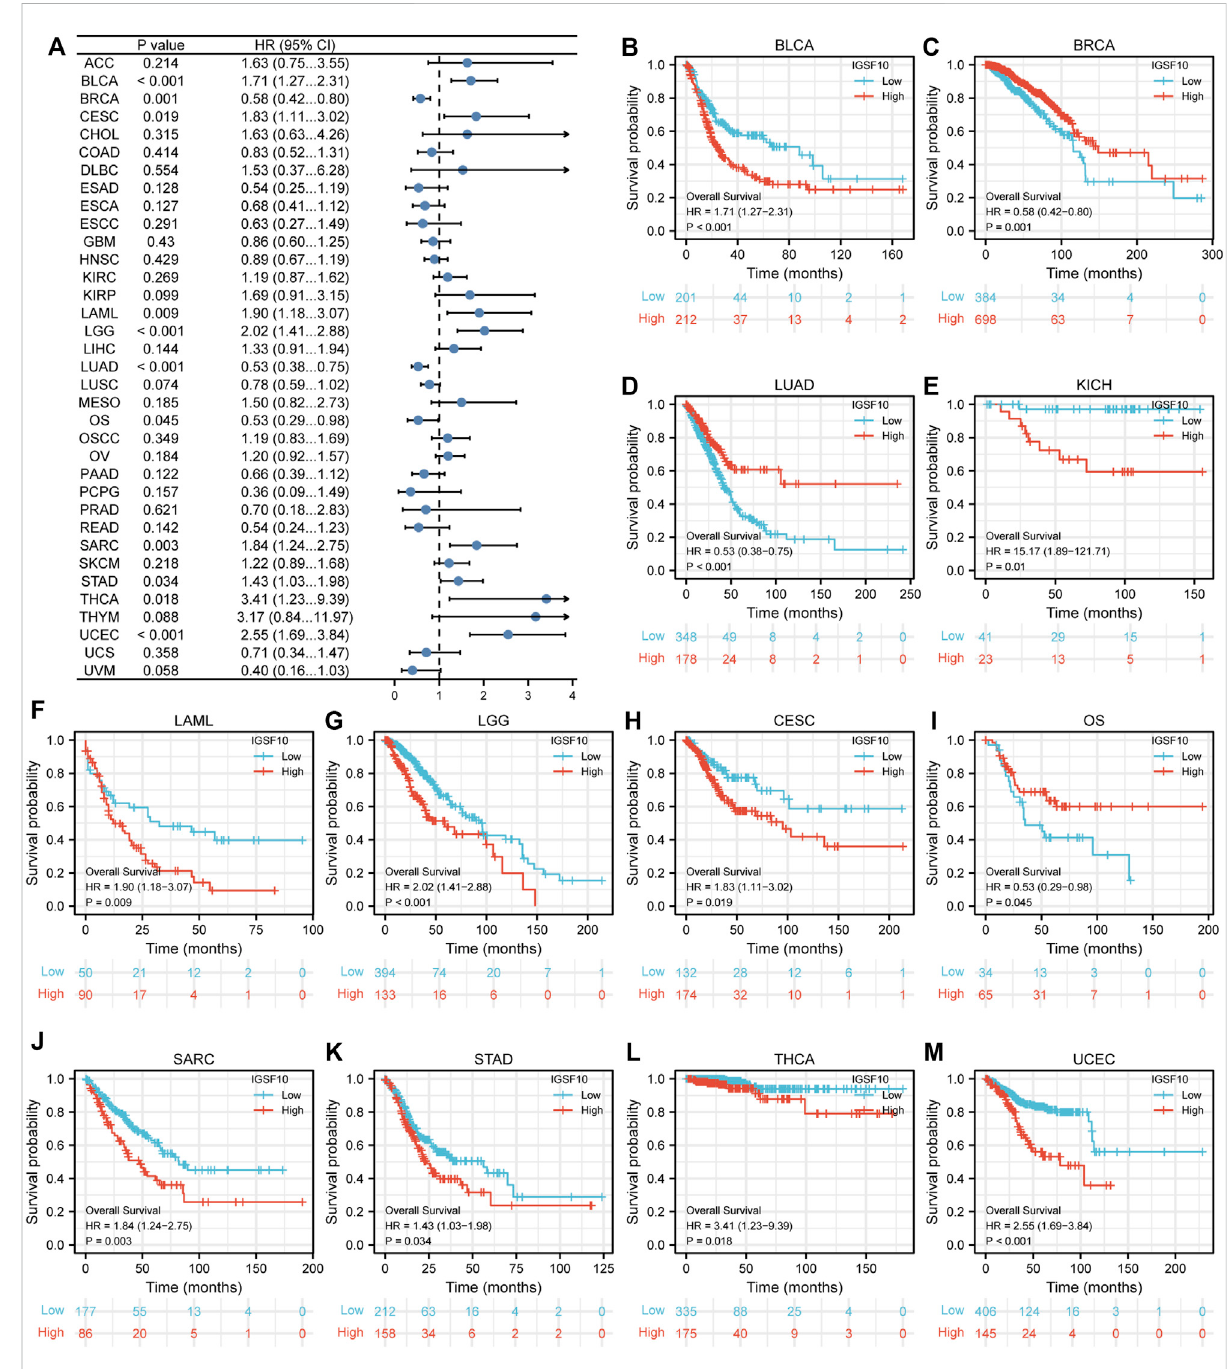
FIGURE 3 Correlationsbetweenthe IGSF10 expressionandoverallsurvival(OS). (A) Forestplotofresultsfromtheunivariatesurvivalanalysisinpan-cancer for OS. (B – M) Kaplan-Meier survival curves showed associations between the IGSF10 expression and